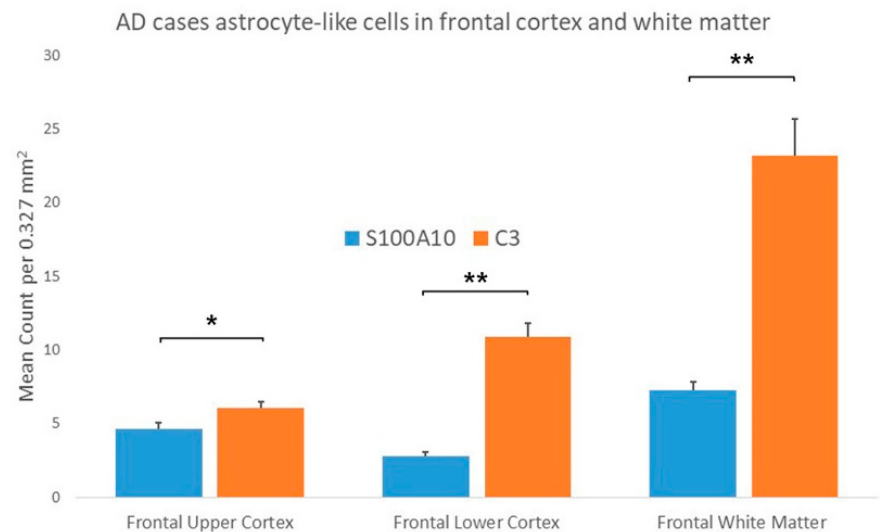
Figure 7. Results comparing the mean counts of C3 and S100A10 immunopositive astrocyte-like cells (ASLCs) in the upper frontal cortex, lower frontal cortex and frontal white matter of AD cases. There were significantly increased numbers of C3 immunopositive ASCLs compared to S100A10 immunopositive ASLCs in all regions but there was least di ff erence in the upper frontal cortex. (* p < 0.01, ** p < 0.001) Results are mean counts +